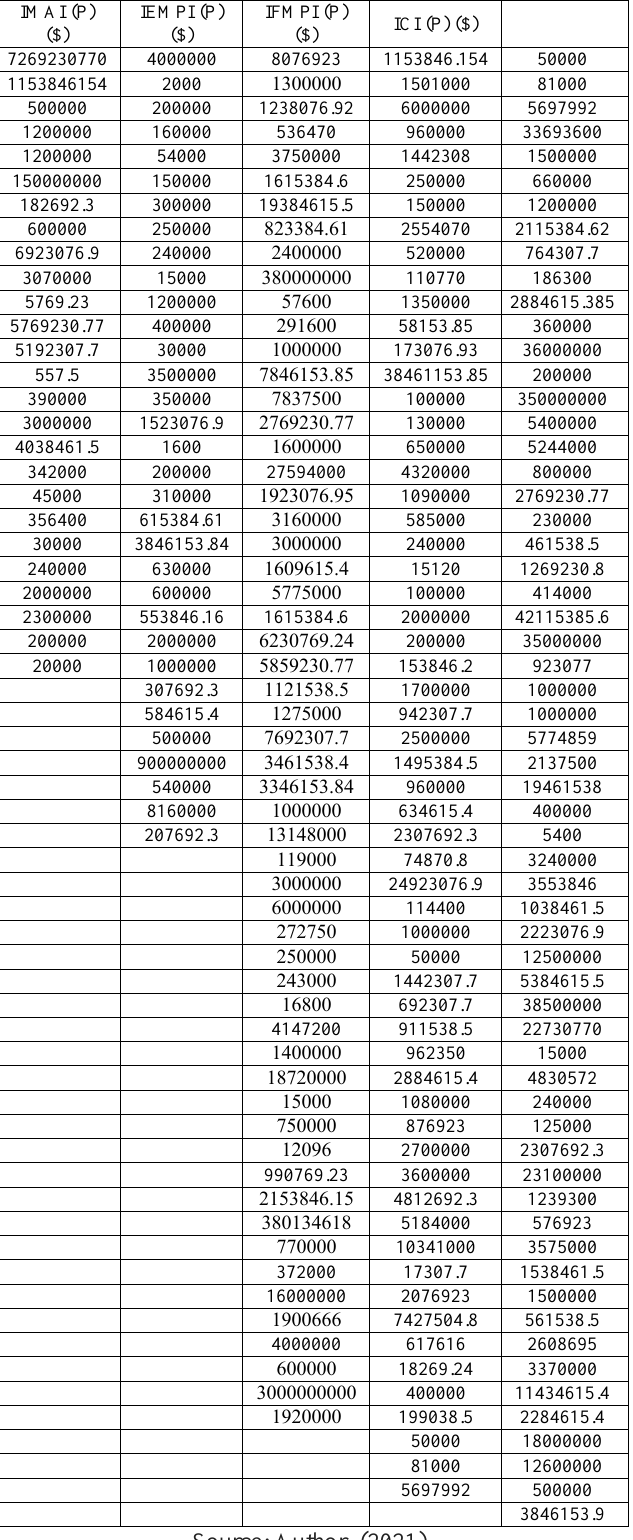
Table 1: The revenue of industrial groups. Table 2: The regression analysis of cost/revenue.